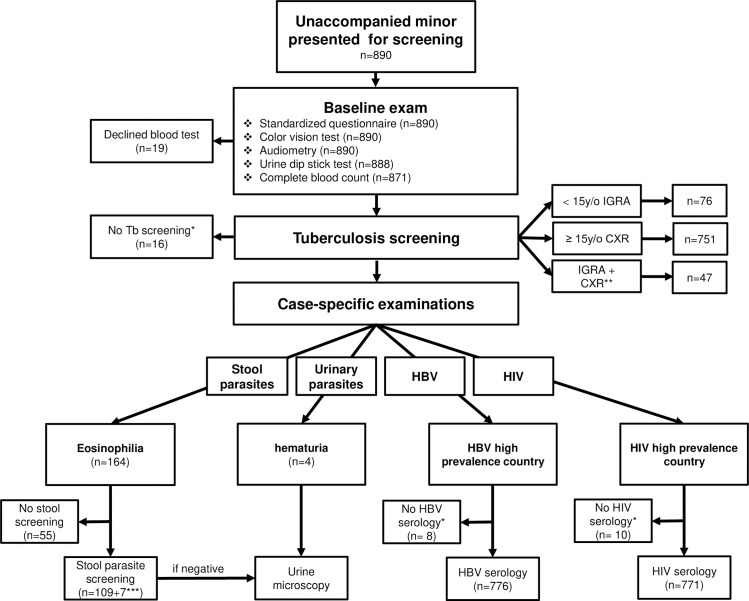
Flowchart of applied screening algorithm in a cohort of unaccompanied refugee minors (n = 890).*Participants refused screening or previously already screened; **comprehensive initial diagnostics in symptomatic patients (fever, cough >2 weeks, loss of weight); ***patients with gastrointestinal symptoms. Based on Pfeil and colleagues [19]. CXR, chest X-ray; HBV, hepatitis B virus; HIV, human immunodeficiency virus; IGRA, interferon gamma release assay; TB, tuberculosis.